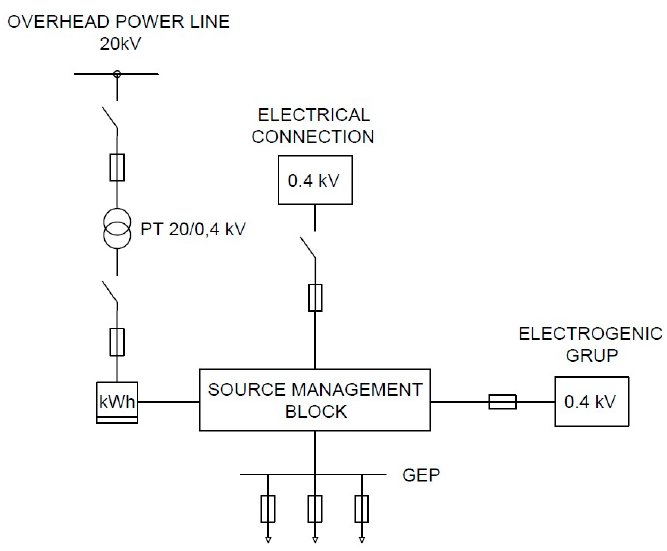
Figure 3. The power supply diagram of a railway station.